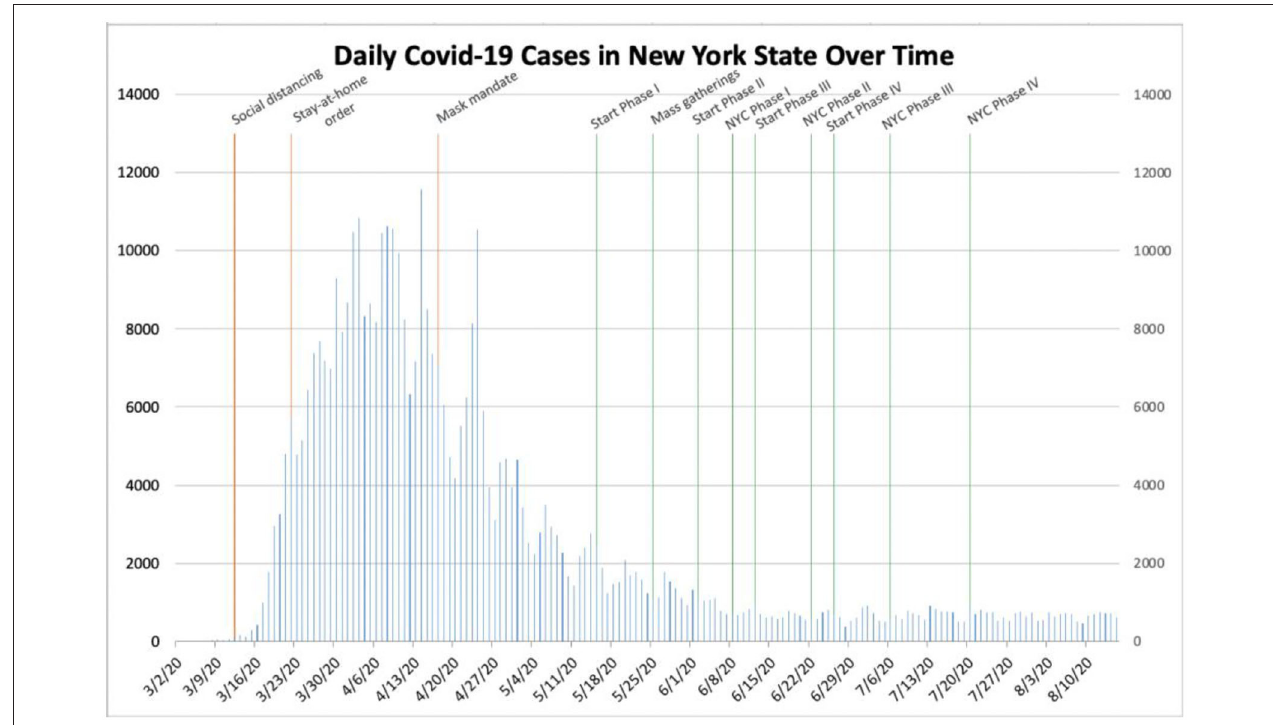
FIGURE 1 | Daily COVID-19 cases in New York